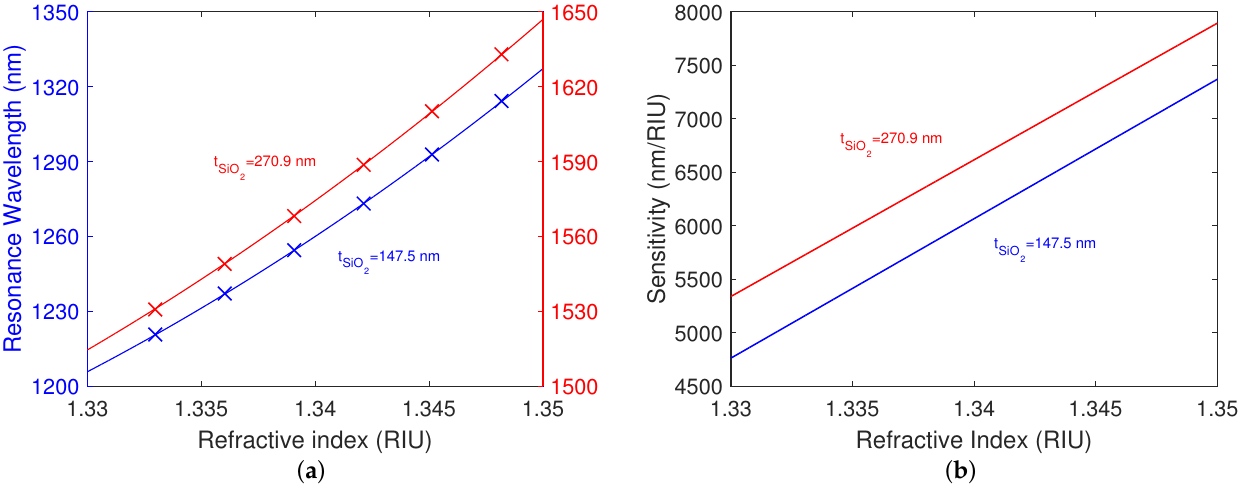
Figure 7. Theoretical resonance wavelength as a function of refractive index of the analyte and second-order polynomial fit for both structures ( a ). Theoretical RI sensitivity for both structures ( b ). Angle of incidence θ = 68 ◦